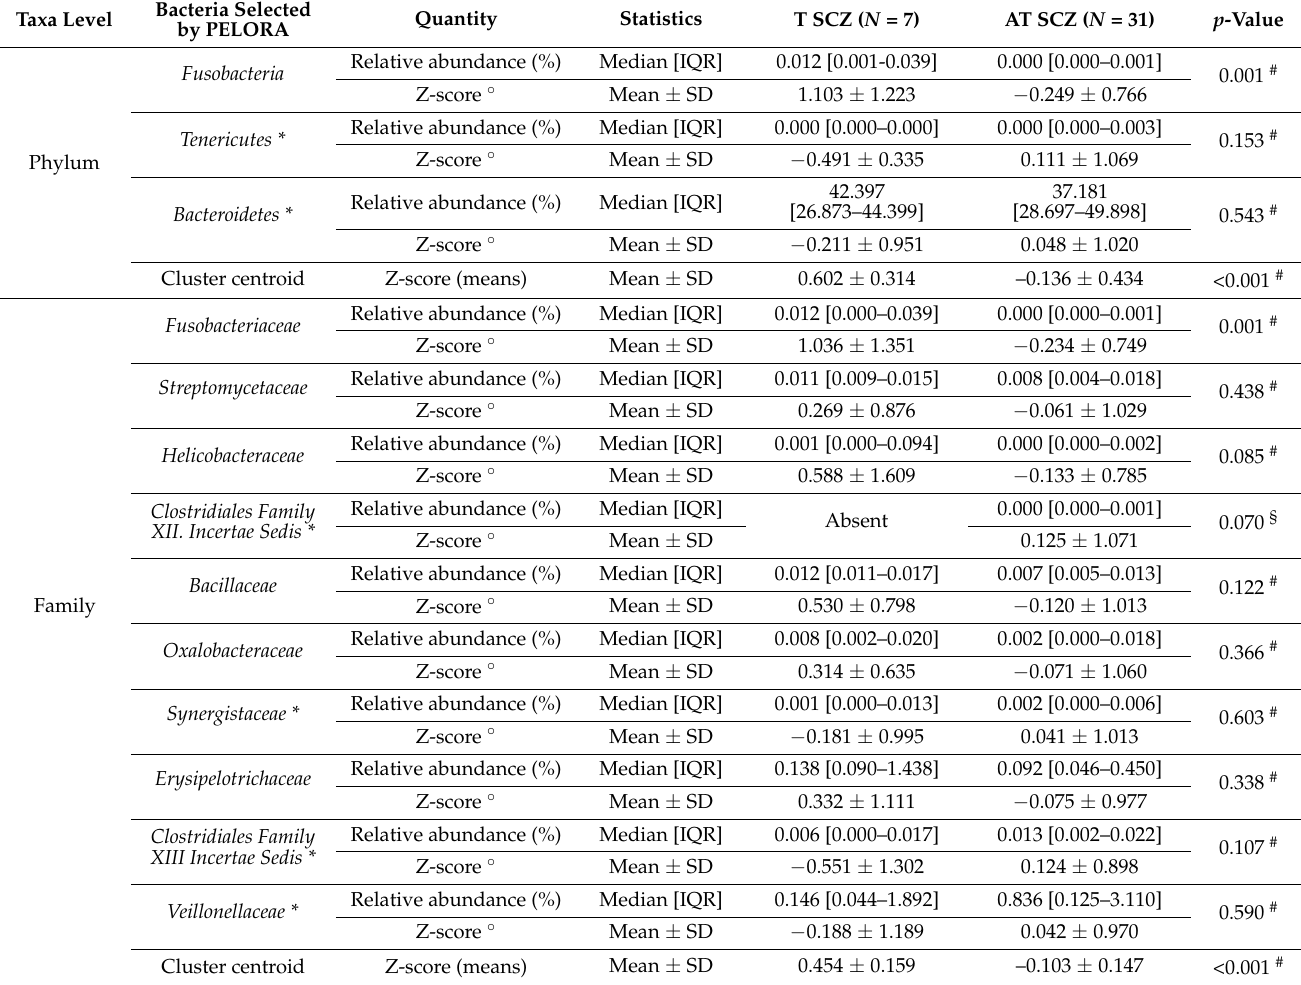
Table 6. Results from Penalized Logistic Regression Analysis (PELORA) algorithm which identifies panels of bacterial popula- tions that best discriminate patients affected by SCZ treated with typical versus atypical antipsychotics (including aripiprazole). Taxa